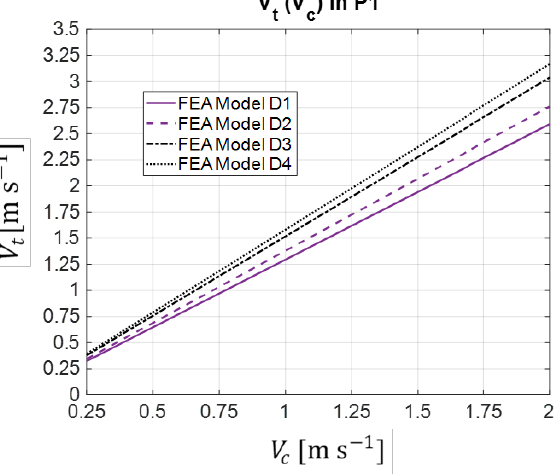
Figure 17. Characteristic 𝑉 𝑡 (𝑉 𝑐 ) in P1, obtained by 2D FEA for models D1, D2, D3, and D4.